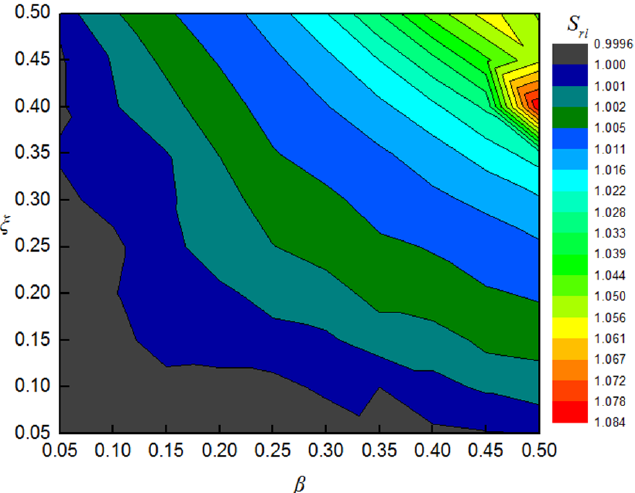
Figure 8. Variation in S rl with β and ξ .